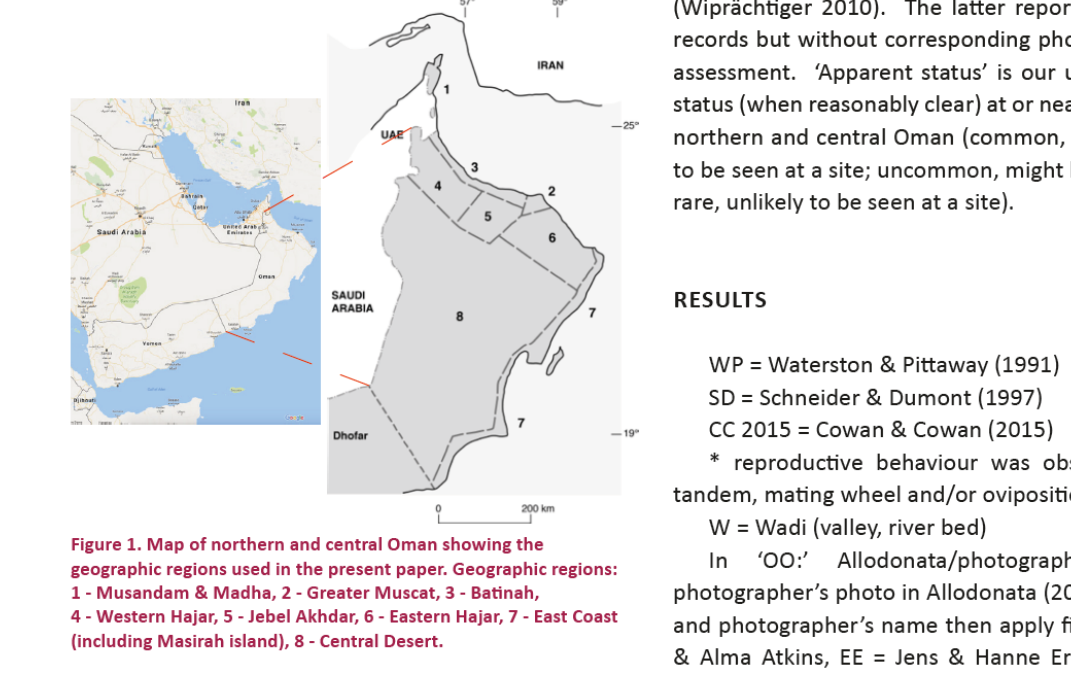
Ffigure 1. Map of norfthern and cenftrafl Oman showfing fthe geographfic regfions used fin fthe presenft paper. Geographfic regfions: 1 - Musandam & Madha, 2 - Greafter Muscaft, 3 - Bafinah, 4 - Wesftern Hajar, 5 - Jebefl Akhdar, 6 - Easftern Hajar, 7 - Easft Coasft (fincfludfing Masfirah fisfland), 8 - Cenftrafl